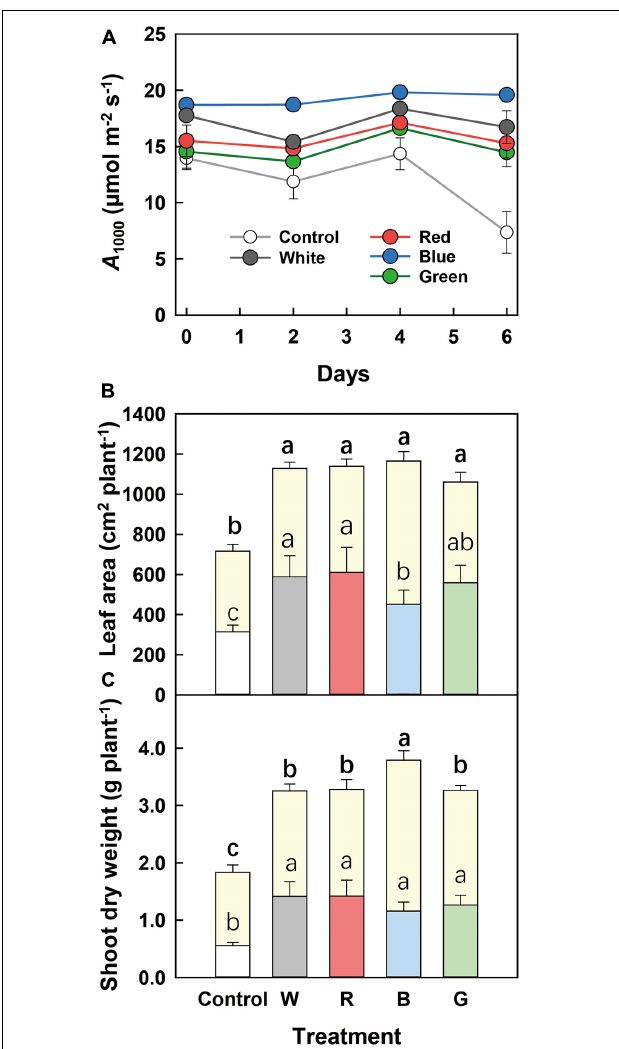
FIGURE 4 | Plant growth and photosynthesis after plant exposure to full sunlight for 1 week. (A) Time course of the steady-state net leaf photosynthesis rate at PPFD of 1,000 µ mol m − 2 s − 1 ( A 1000 ) during 6 days of full solar light exposure. (B) Leaf area and (C) shoot dry weight of cucumber plants before and after 7 days of full solar light exposure, indicated by the lower and upper part of columns, respectively. Before full solar light exposure, cucumber plants were grown for 10 days under different supplemental light spectra: Control (C, shade solar light), white (W), red (R), blue (B), and green (G). Mean values ± SEM of three to five biological replicates in one experimental batch are shown ( n = 3–5). Different letters indicate a significant treatment effect ( p <